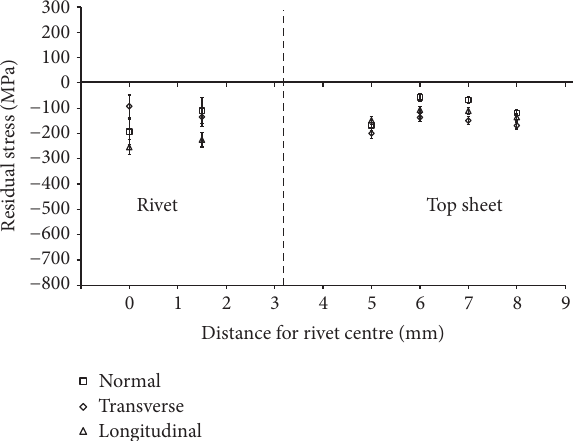
Figure 12: Distribution of residual in the bottom sheet and rivet leg of joint II along GG line as depicted in Figure